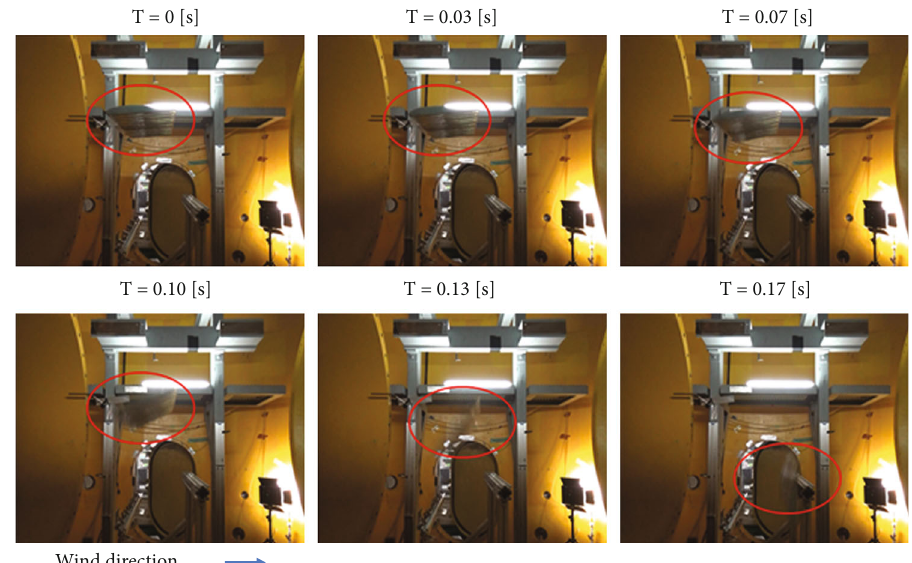
Figure 14: The time series pictures of test model collapsing to the front at RA of -9 degrees.